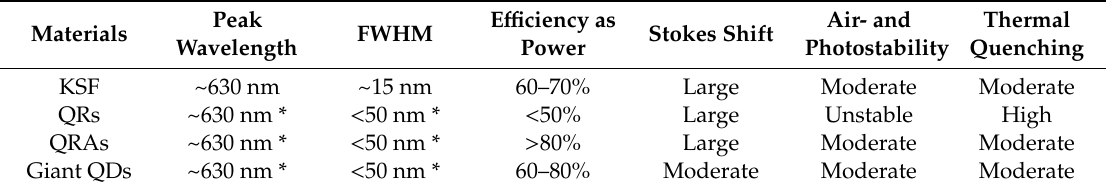
Table 2. Optical properties of narrow emitting phosphors for white-light LED (WLED) application. Materials